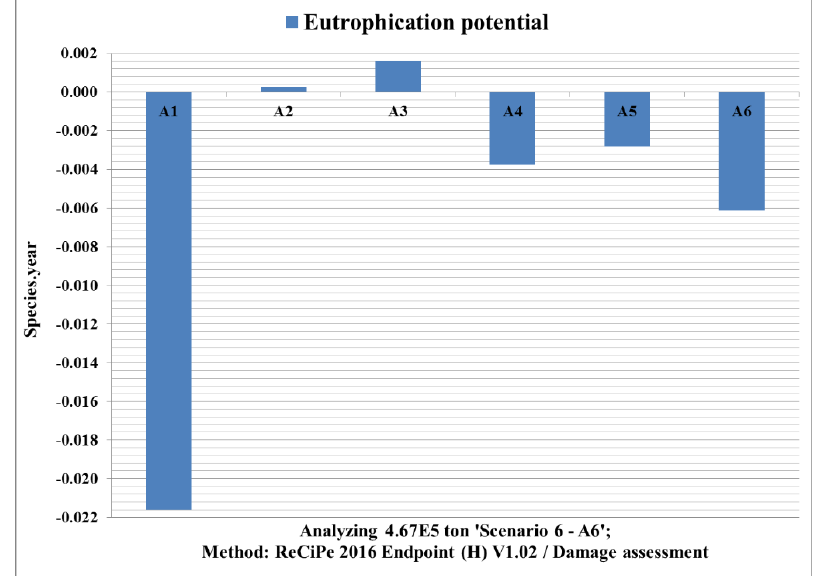
Figure 5. Eutrophication impact potentials.